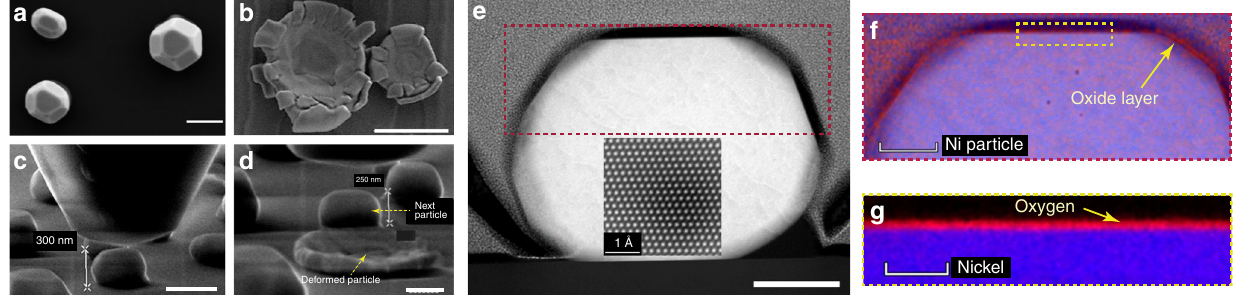
Fig. 1 Compression tests of Ni nanoparticles. a , b High-resolution scanning electron microscopy (HR-SEM) images of particles before ( a ) and after ( b ) compression. c , d In situ images of a particle before ( c ) and after ( d ) compression. e STEM image of a particle prior to compression. The lattice image in the inset con fi rms that the particle is single crystalline. f , g STEM EDS map showing a thin, 3 – 4-nm oxide layer on the particle surface. The scale bars shown in a – d , e , f , and g correspond to 500, 100, 50, and 20 nm,